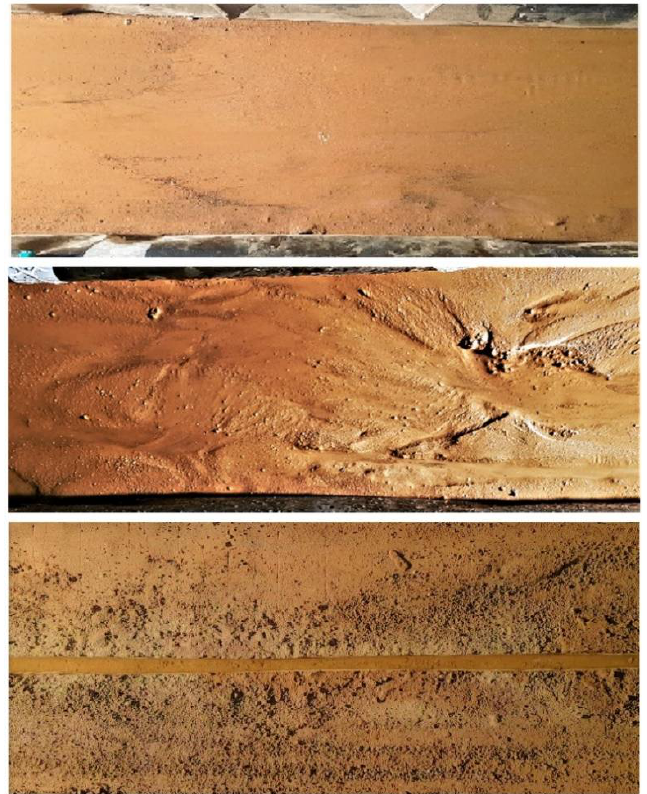
Figure 2. Photographs of the scanned surface area (see Figure 1) with the flat plane surface ( top ), the eroded plane surface ( middle ) and the artificial rill ( bottom ). The longitudinal dimension of each photograph is 0.5 m.